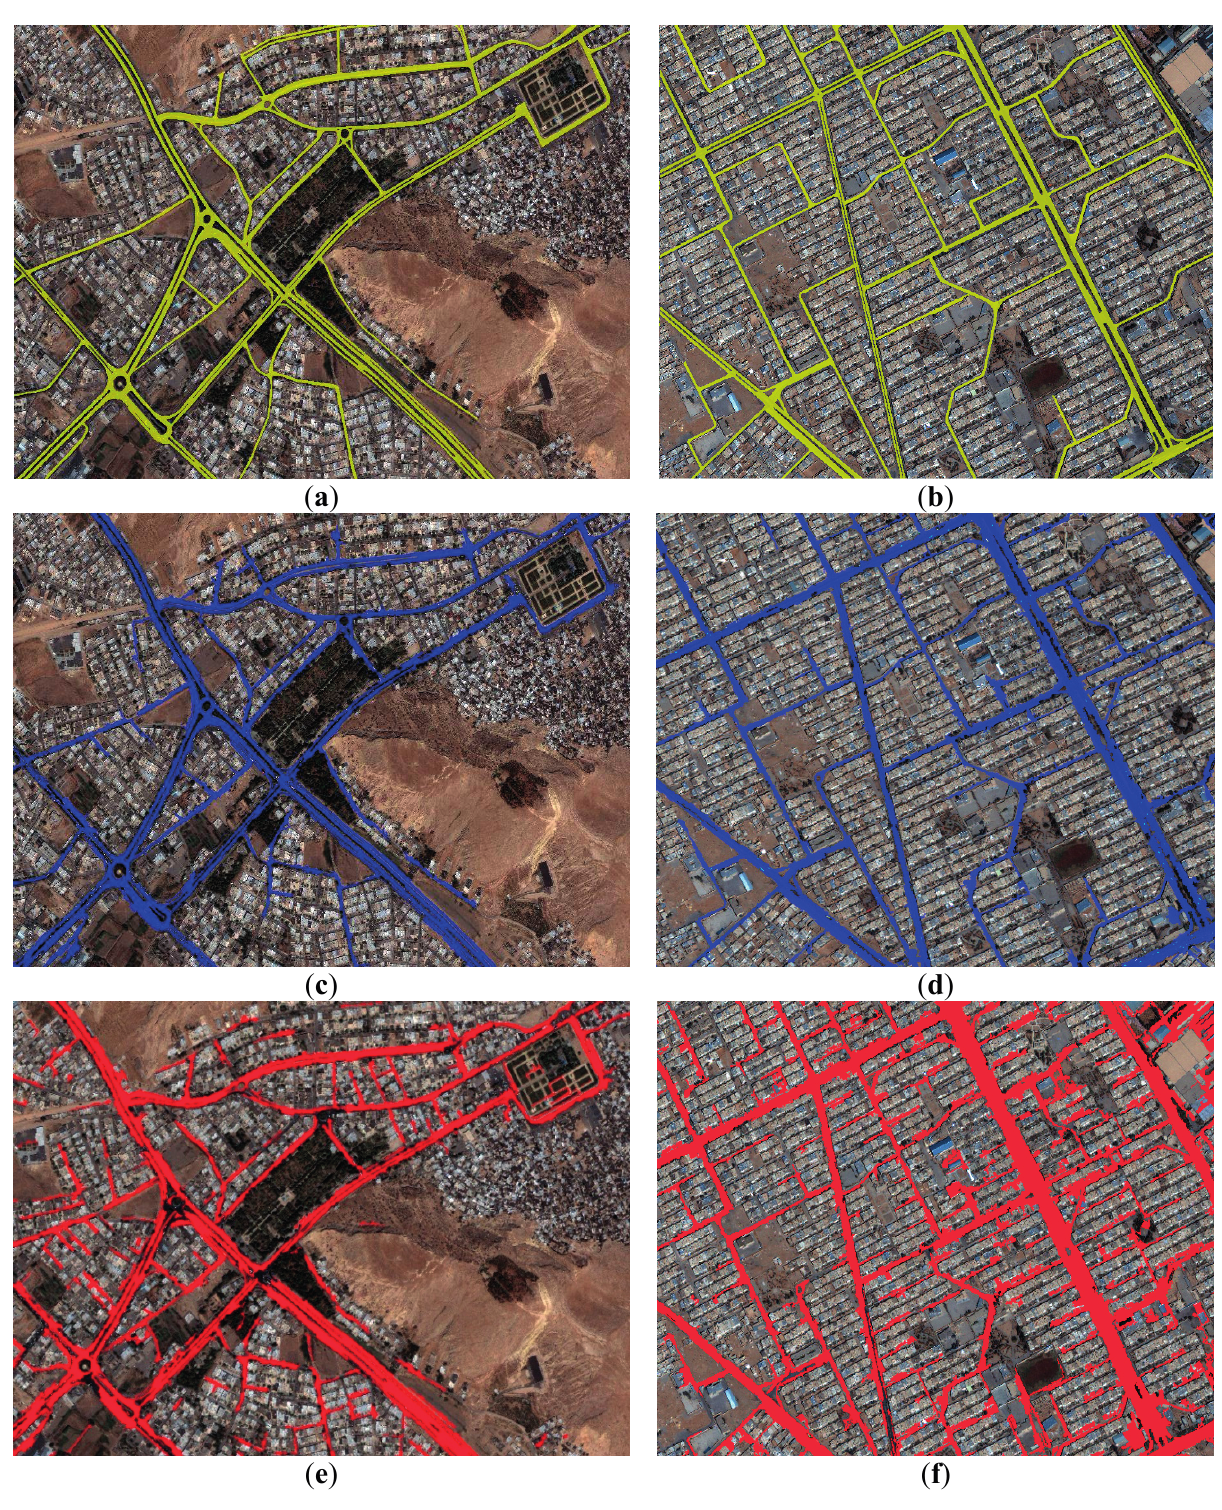
Figure 12. ( a , b ) The referenced road data of Shiraz and Yazd IKONOS images. ( c , d ) The final result of proposed T2 FLS after enhancement. ( e , f ) The final result of T1 FLS after